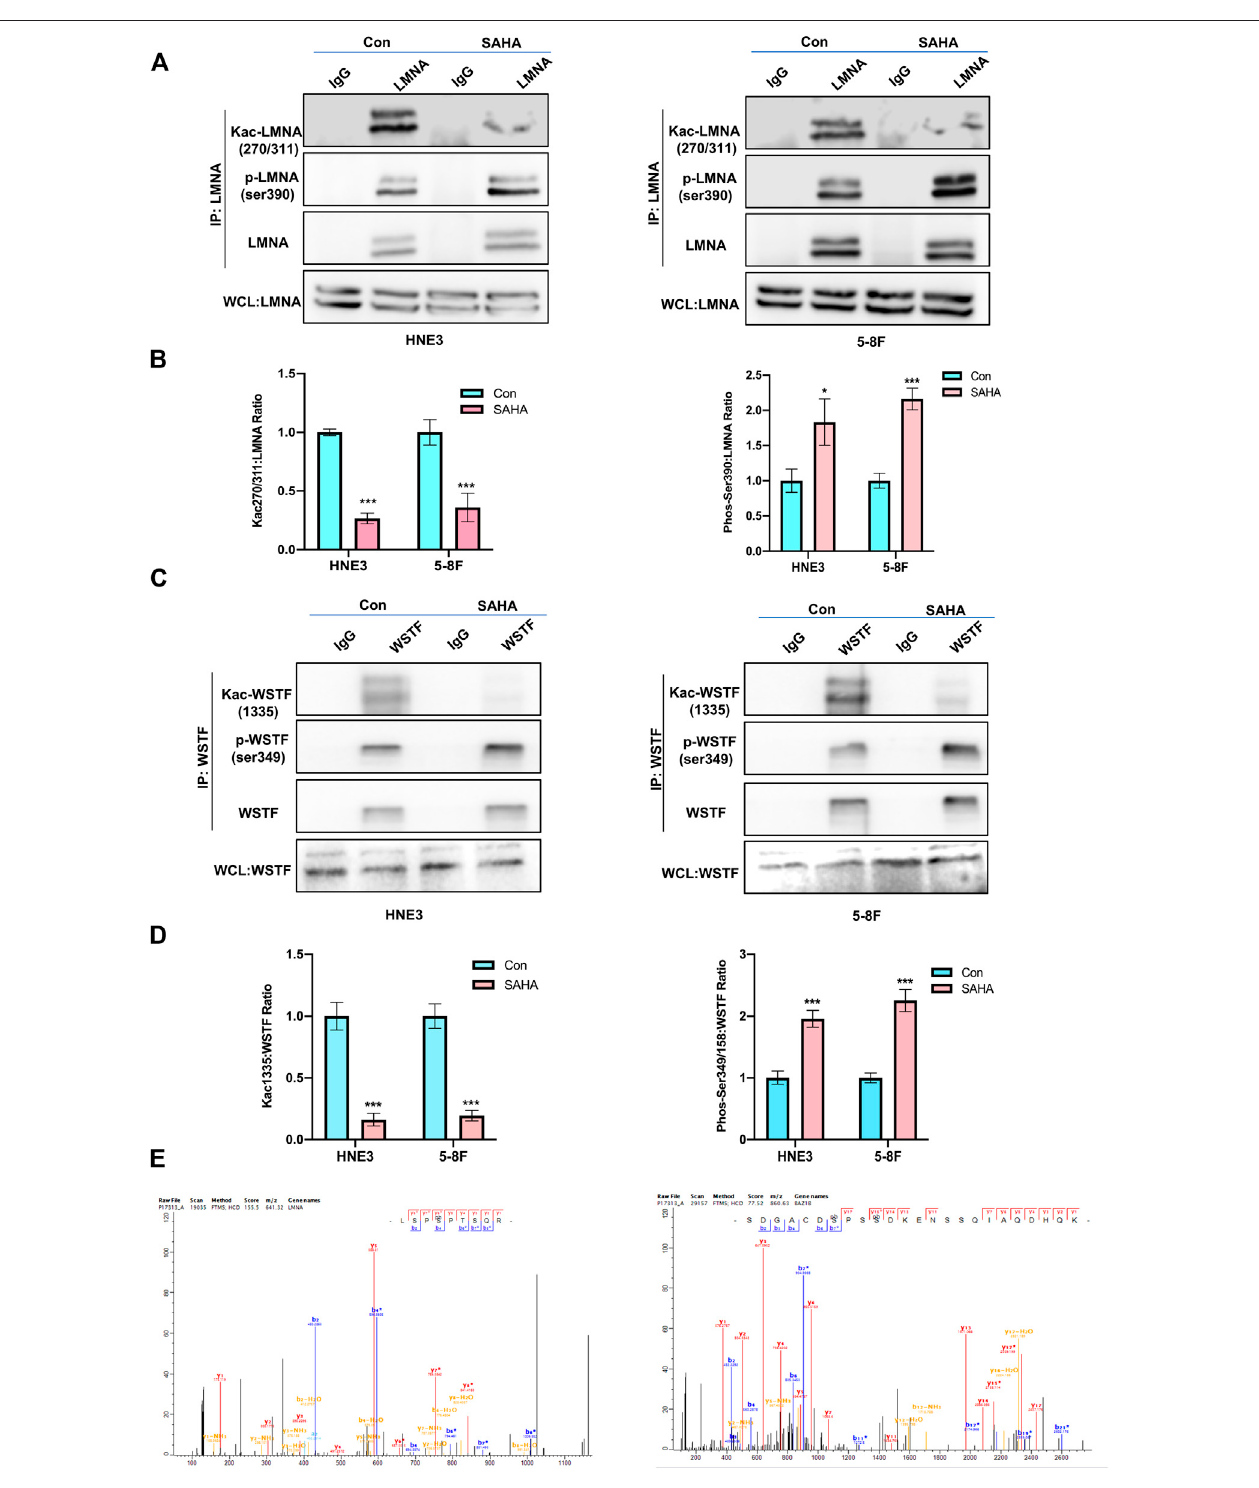
FIGURE 7 | Validation of the key phosphorylated and acetylated proteins by SAHA. (A , B) Immunoblot analysis of LMNA phosphorylation and acetylation in NPC cellswithorwithoutSAHAtreatment.NPCcells(HNE3and5 – 8 F)weretreatedwithorwithoutSAHA(6 μ M)for24 h;WCLswereprecipitatedwithanti-LMNAorcontrol antibodies; precipitated proteins and WCLs were analyzed by immunoblotting with indicated antibodies. Protein levels of LMNA are shown in (A) , and the statistical analysis of all samples is shown in (B) . * denotes p < 0.05, ***denotes p < 0.001. Error bars represent ± SD of triplicate experiments. (C , D) Immunoblot analysis of WSTF phosphorylation and acetylation in NPC cells with or without SAHA treatment. NPC cells (HNE3 and 5 – 8 F) were treated with or without SAHA (6 μ M) for 24 h;